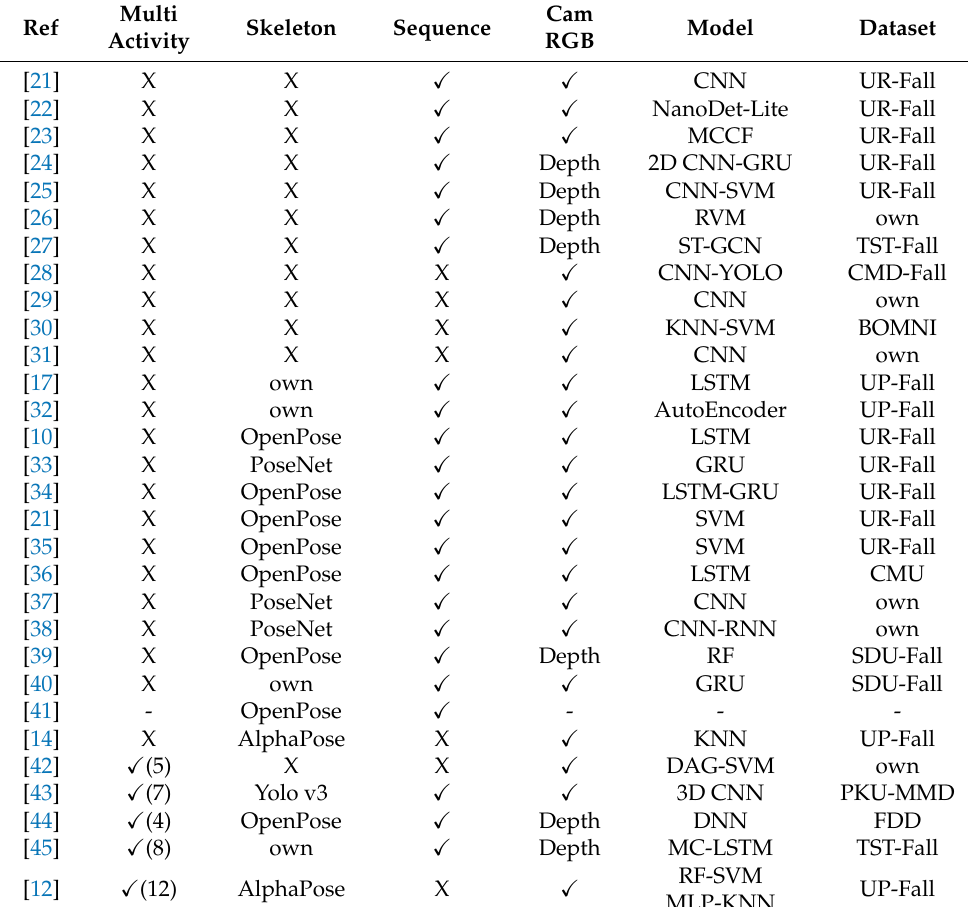
Table 1. State of the art for human activity recognition by video images. Please consider the following meaning (cid:88) —Yes,